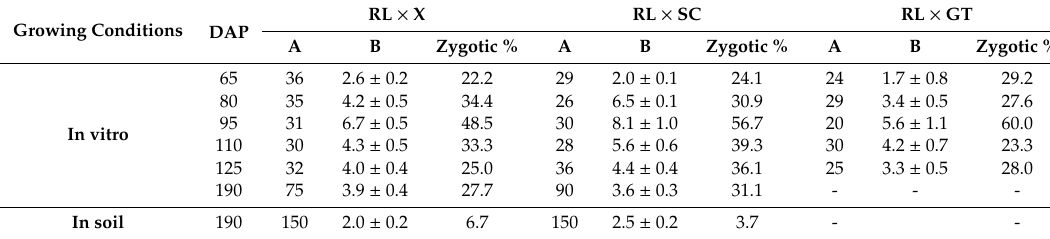
Table 2. Recovery of zygotic embryos at di ff erent time intervals from three